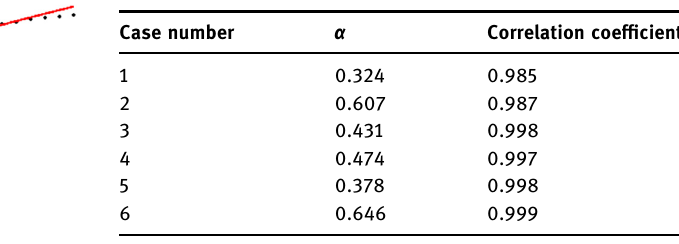
Table 6: Model parameters based on the fractional de fi ned